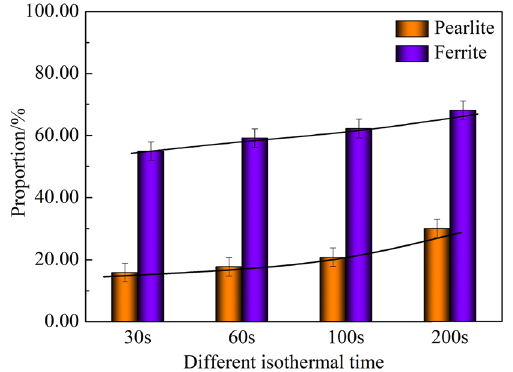
Figure 4: Proportion statistics of pearlite and ferrite under the conditions of di ff erent isothermal